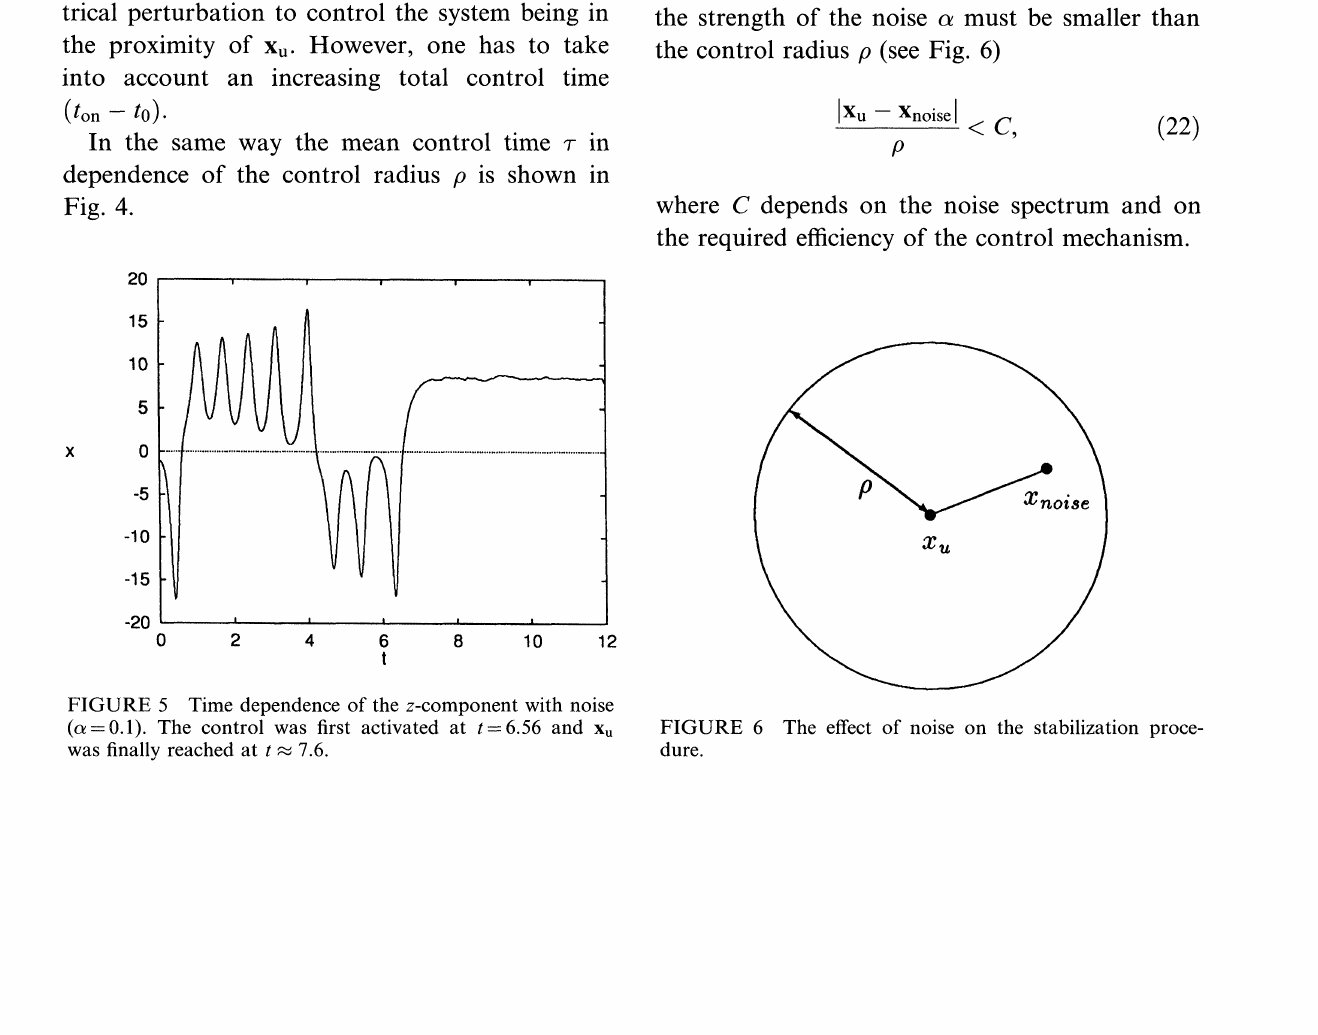
FIGURE 5 Time dependence of the z-component with noise (c=O.1). The control was first activated at t=6.56 and xu was finally reached at 7.6.